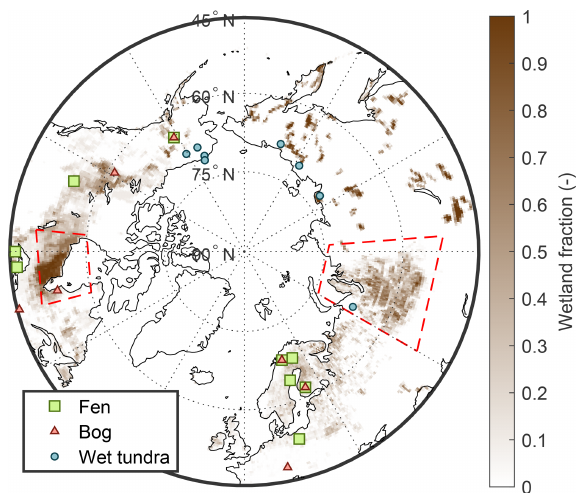
Figure 1. Map showing the locations of the EC measurements. The distribution of wetlands shown in the figure is based on Xu et al. (2018). Hudson Bay lowlands (50–60 ◦ N, 75–96 ◦ W) and west- ern Siberian lowlands (52–74 ◦ N, 60–94.5 ◦ E) are highlighted with dashed red